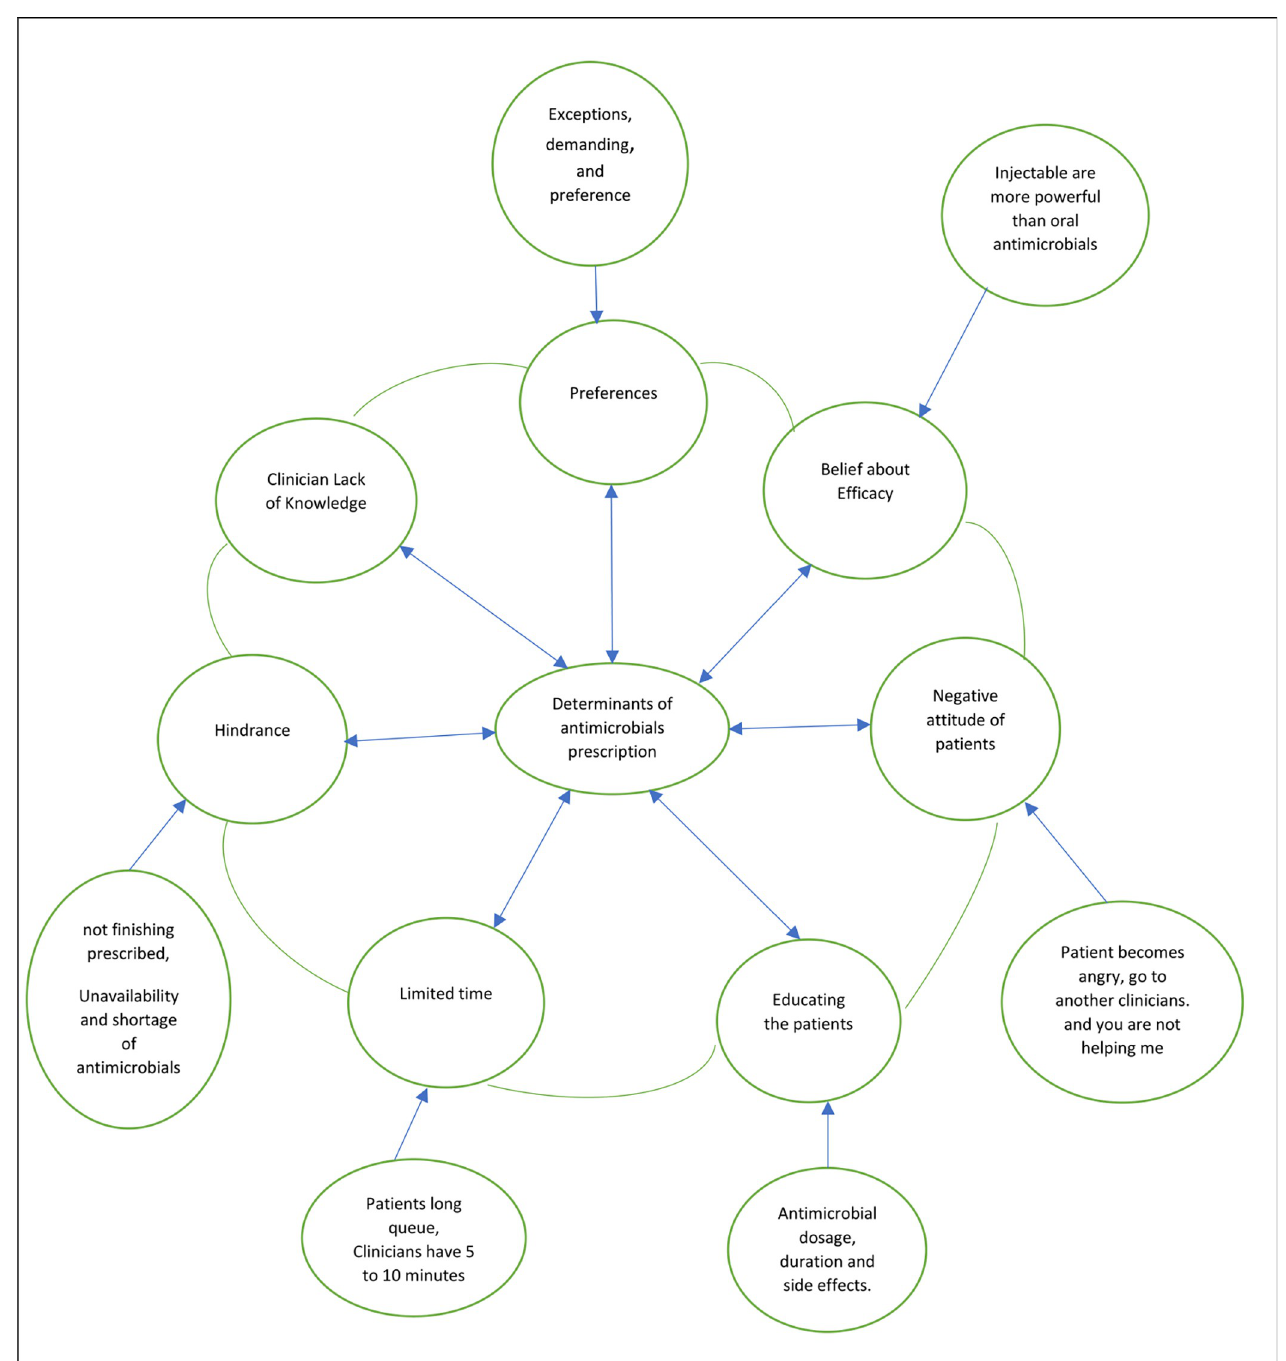
Fig 1. Map of sub themes and major